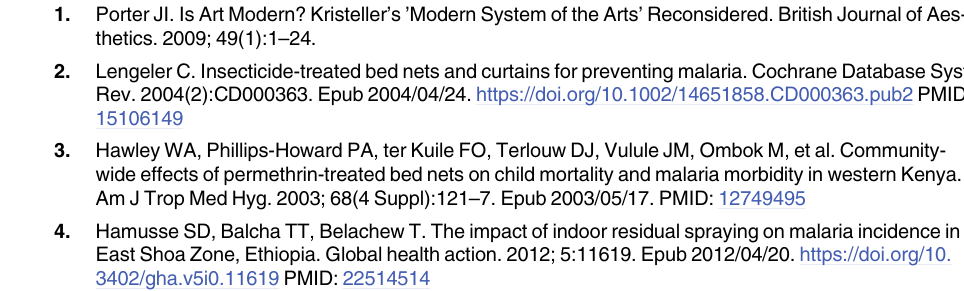
S3 Table. ELISA PCR results. S4 Table. Rainfall